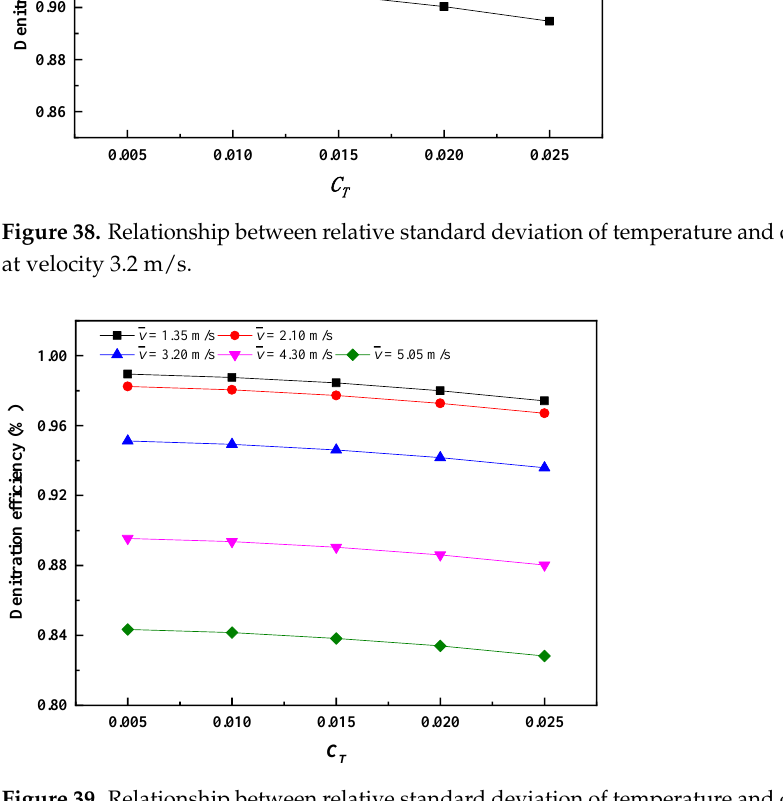
Figure 39. Relationship between relative standard deviation of temperature and denitration efficiency under different velocities.